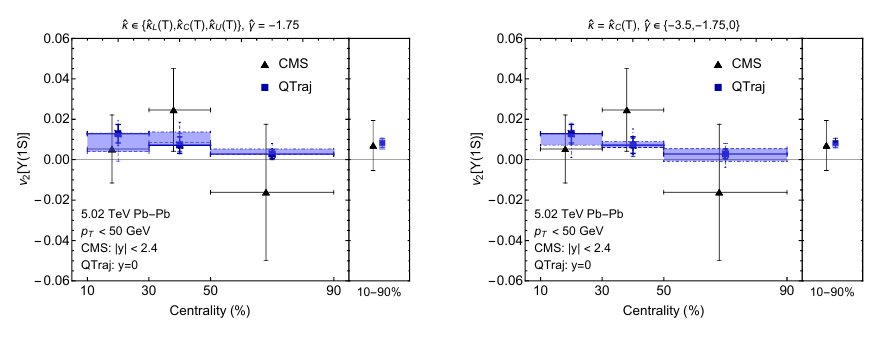
Figure 2. Elliptic flow v 2 of the ⌥ (1 S ) as a function of centrality compared to experimental mea- surements of the CMS [41] collaboration. The bands represent uncertainties as in Fig. 1. Taken from Ref. [11].